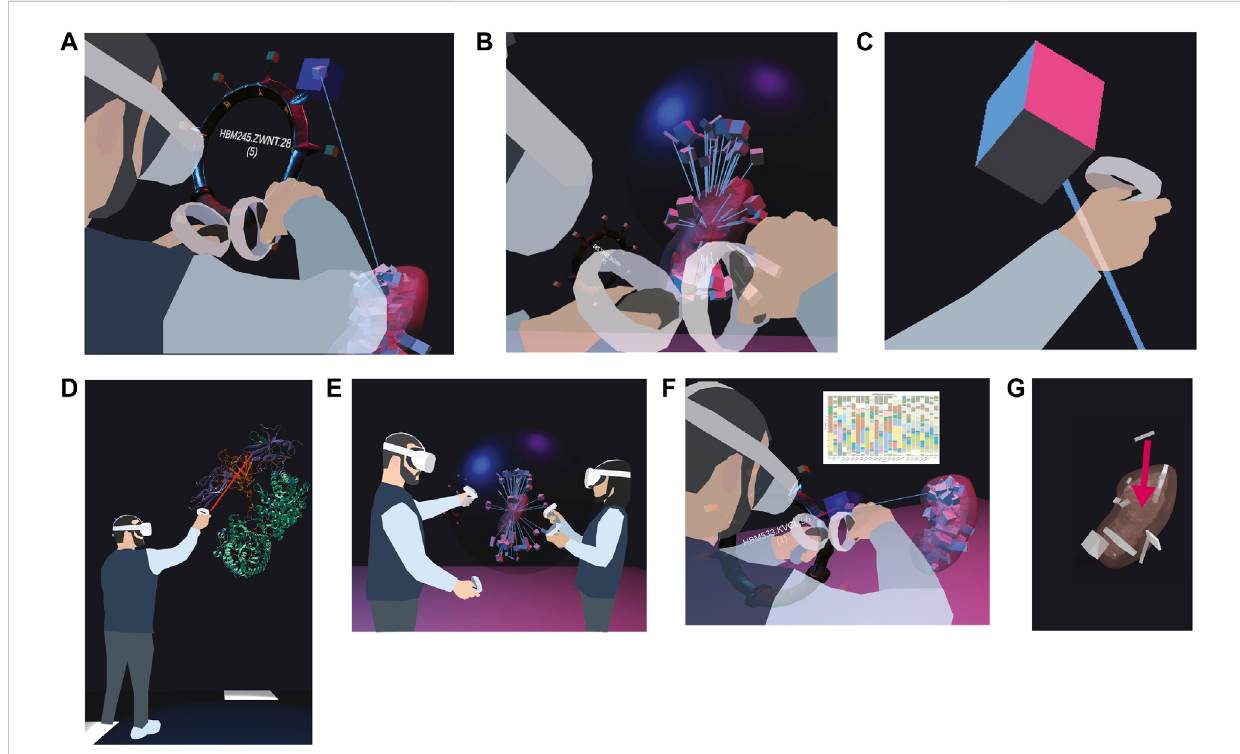
FIGURE 4 Featurescurrentlyprototypedorplanned. (A) Auserpicksatissueblockofinterestandstoresitinaring-shapedwristpocket. (B) Auserdisentangles overlappingtissueblockswithadarkblueprobingspherebyextrudingthemfromtheirsharedcentroid. (C) Auserviewsthecolor-codedcelltypesinside a selected tissue block. (D) A user inspects an enlarged protein (source: https://www.rcsb.org/3d-view/5W21/1). (E) Two users explore the HRA Organ Gallery together. (F) Bar graphs can visualize cell type counts for a selected tissue block. (G) A user can correct a misregistered tissue block by manually picking it up and moving it to the correct